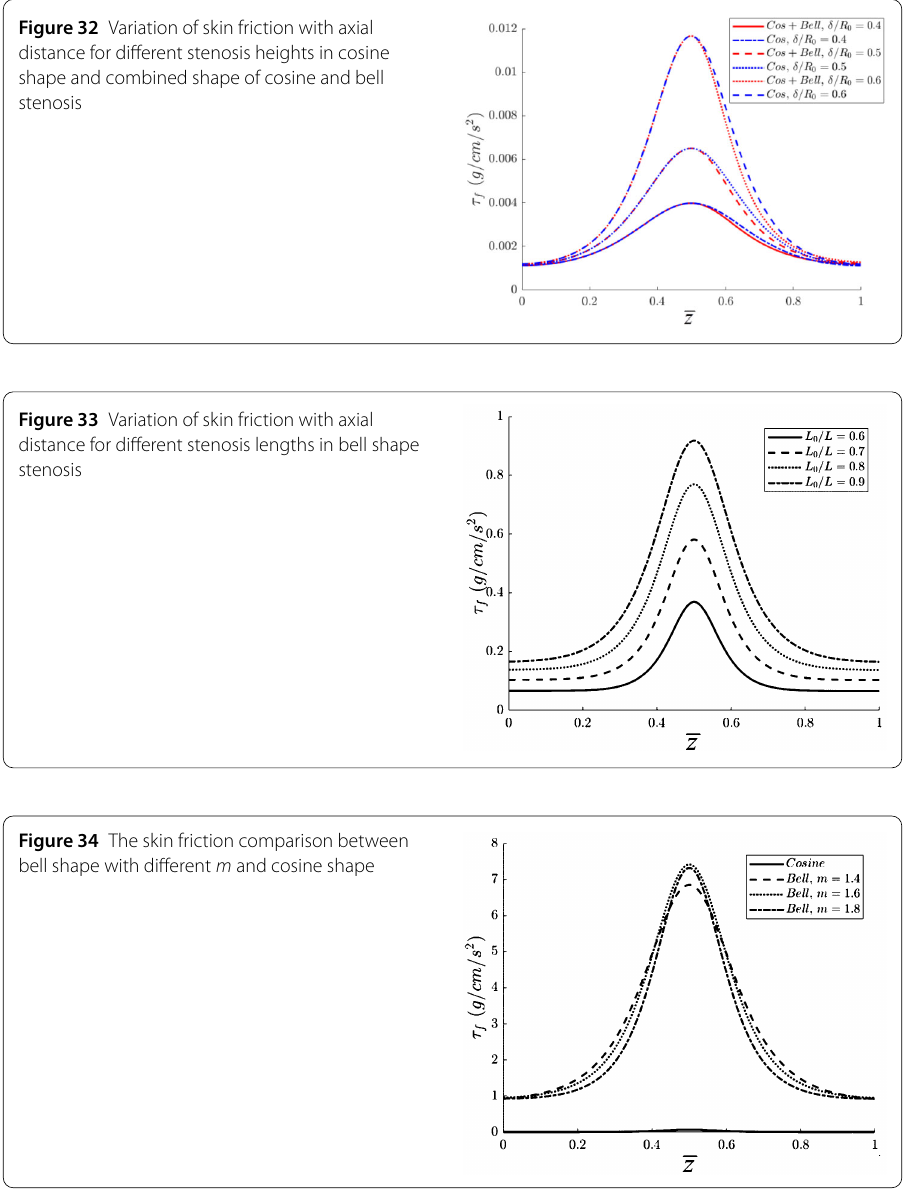
The flow rate behavior of our work and that of J. Venkatsan and S Sriyab’s study with the same single shape are quite different phenomena because of the different non-Newtonian model. The resistance to the flow behavior contradicts the flow rate. The flow rate de- creases with the increase of stenosis height in the bell shape and combined shape (bell shape and cosine shape), which is contrary to the results of J. Venkatsan and S. Sriyab. However, it increases with the increase of stenosis height in the cosine shape and com- bined shape (cosine shape and bell shape), which accords with the results of J. Venkatsan and S. Sriyab. The flow rate in the cosine shape is considerably lower than in the bell shape, while the resistance to the flow in the cosine shape is higher than in the bell shape. The resistance to flow in the combined shape is different from the single shape from the center to the exit of the stenosed